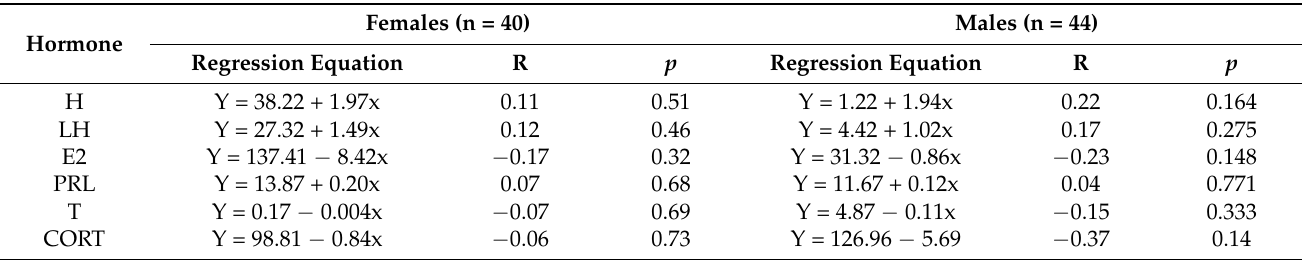
Table 7. Linear regression of FSH, LH, T, E2, PRL, CORT and PRED in TAC+ grafted female and male patients, by concentration of TAC.